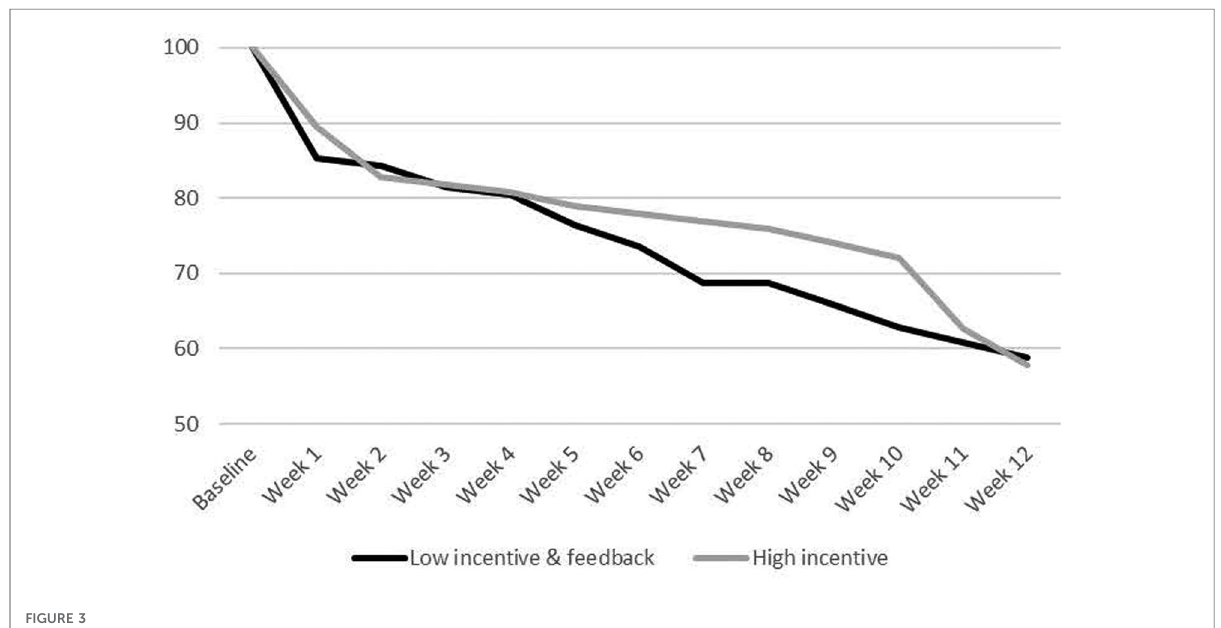
FIGURE 3 Length of Time until Study